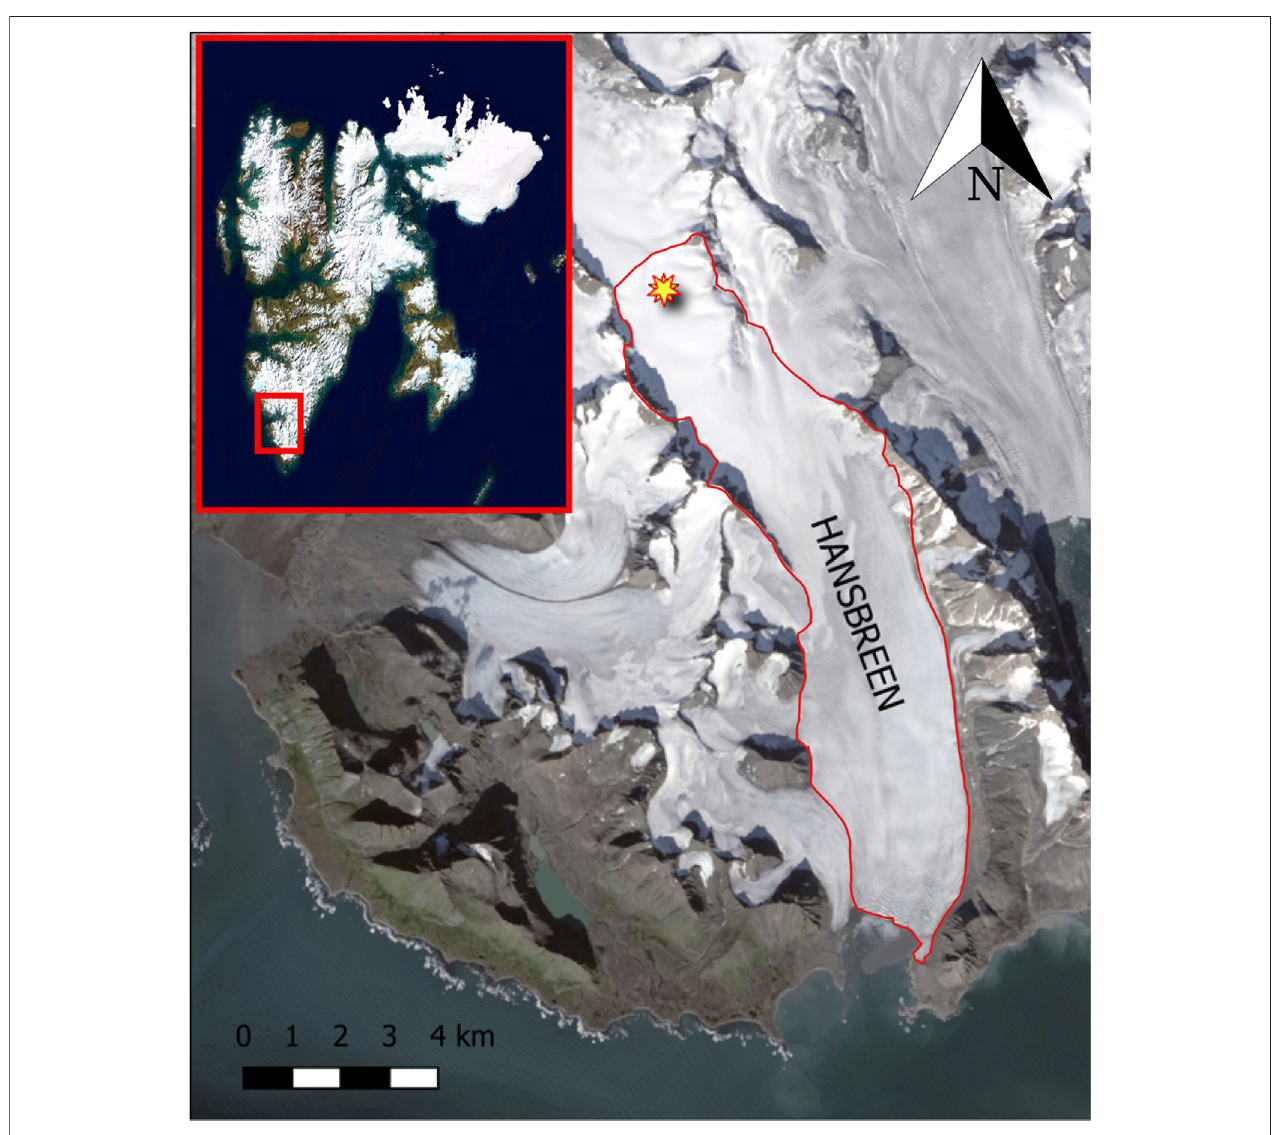
FIGURE 1 | Location of the Hansbreen (inset panel) and the sampling site during the summer season (both marked with a star marker) (Norwegian Polar Institute/ USGS Landsat). The red contour indicates the glacier basin (see https://toposvalbard.npolar.no/ for a detailed map).